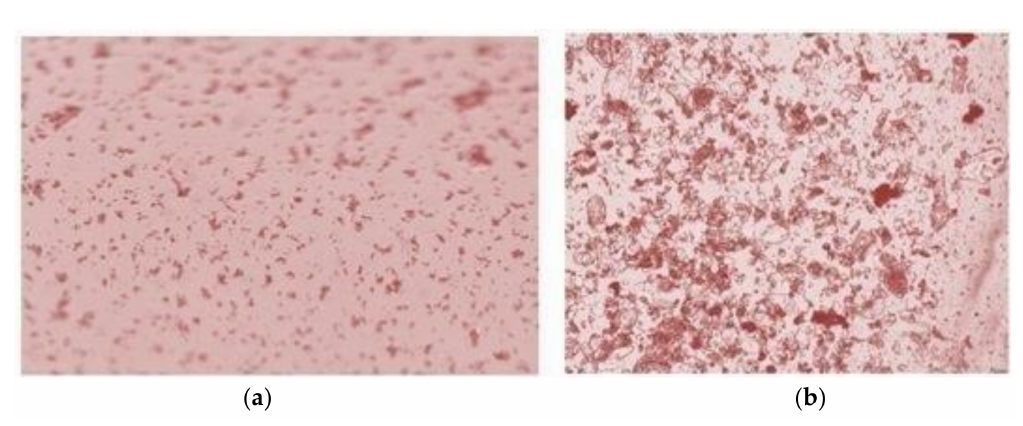
Figure 10. Microscopic view of the biological suspension samples before ( a ) and after ( b ) the purification